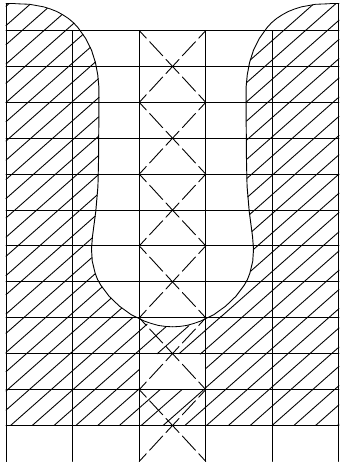
Figure 21. Danger model of load distribution on the steel storage racks with bracings.